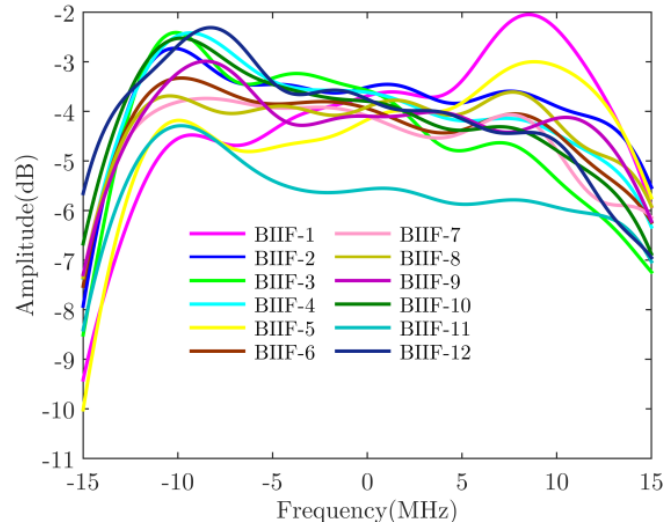
Figure 8. BIIF-5 amplitude characteristic.